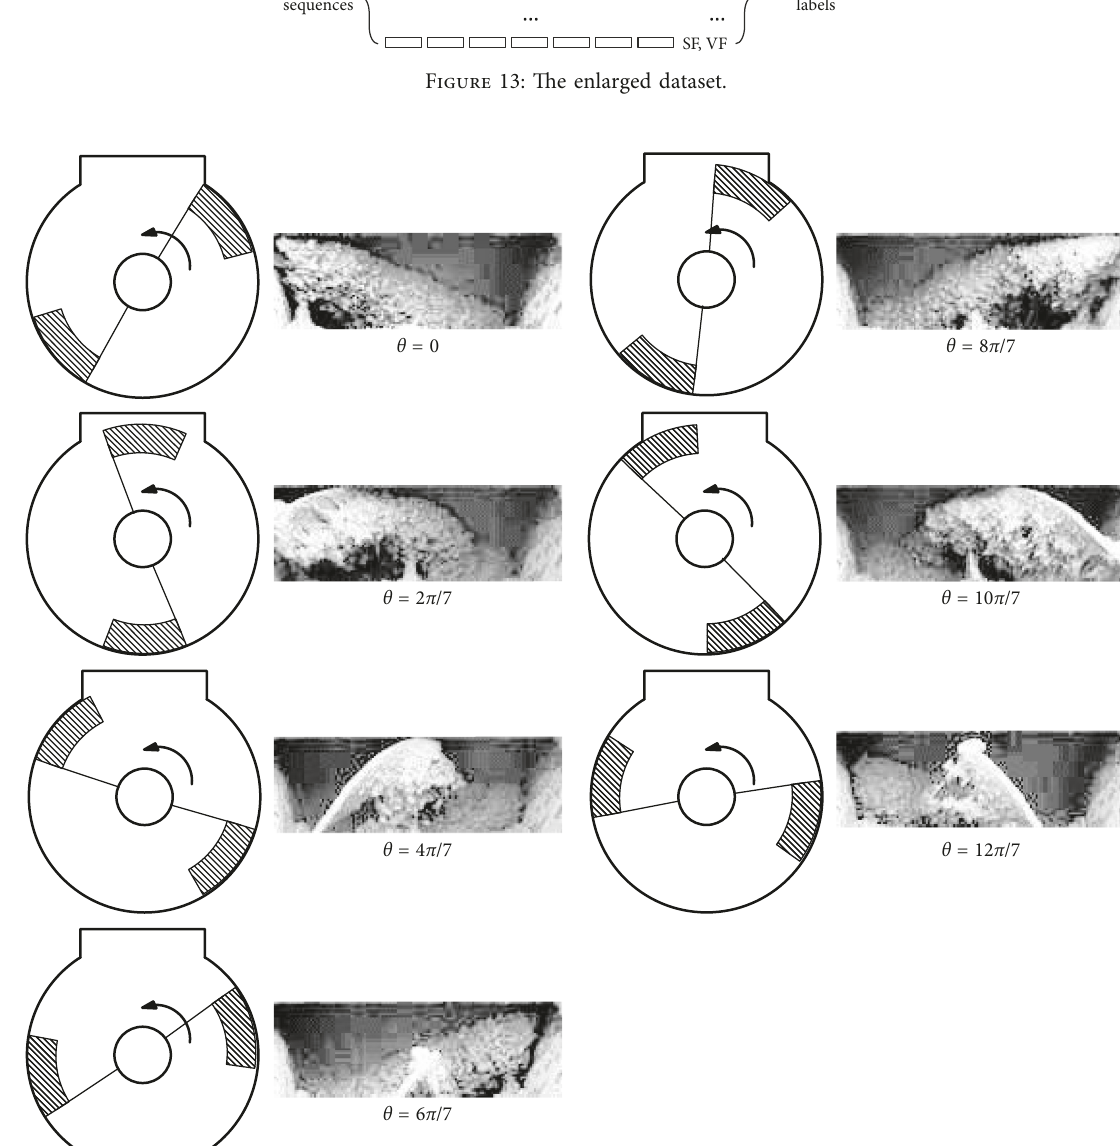
Figure 14: Rotating blade phase angle and the corresponding